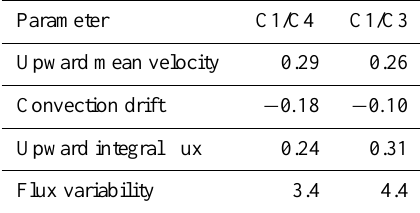
Fig. 5. Overview of an upflowing ion event on 14 August 2001. The format is the same as that in Fig. 2.